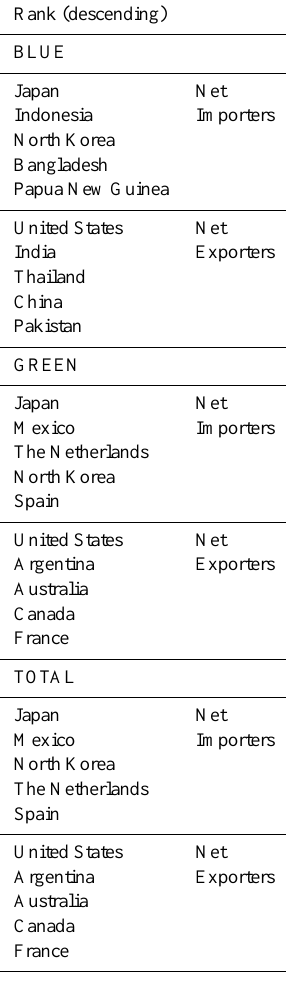
Table 1. Rank of the top 5 net importers and net exporters for blue, green and total